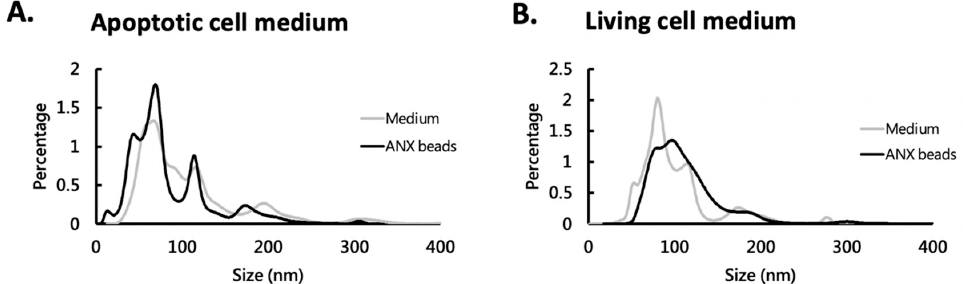
Figure 3. Comparison of particle size profile of the EVs in medium and that captured by ANX beads. The EVs in cultured medium with apoptotic cells ( A ) and living cells ( B ) were either analyzed directly by nanoparticle tracking analysis (NTA) or captured with ANX beads, eluted, and analyzed by